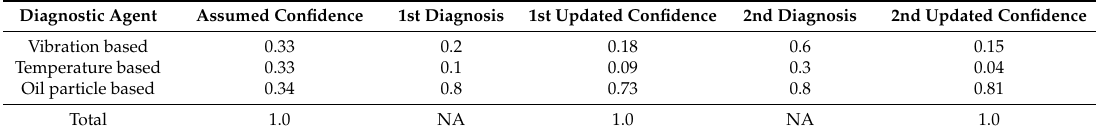
Table 4. Sensitivity analysis of initial equal confidence levels after two hypothetical